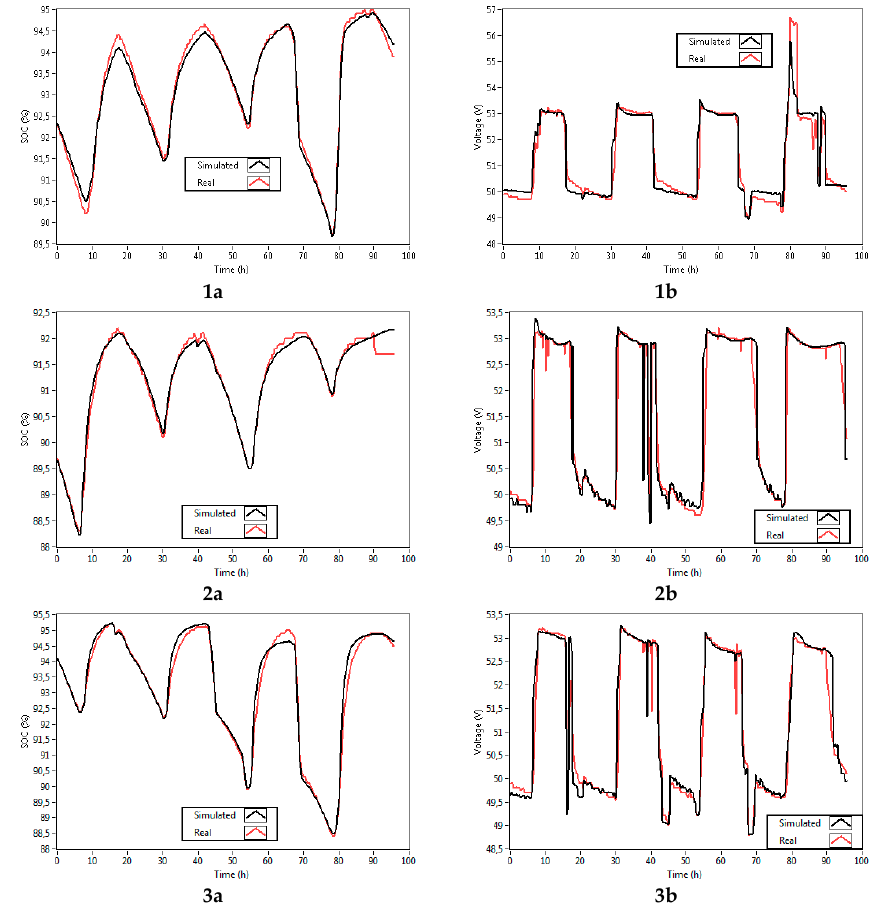
Figure 7. Battery voltage measurements (red plot) and simulation (black plot) results obtained by PSO + P algorithm identified parameters. 1 – 3a represent the battery state of charge (SOC) signals, and 1 – 3b represent the battery voltage signals.